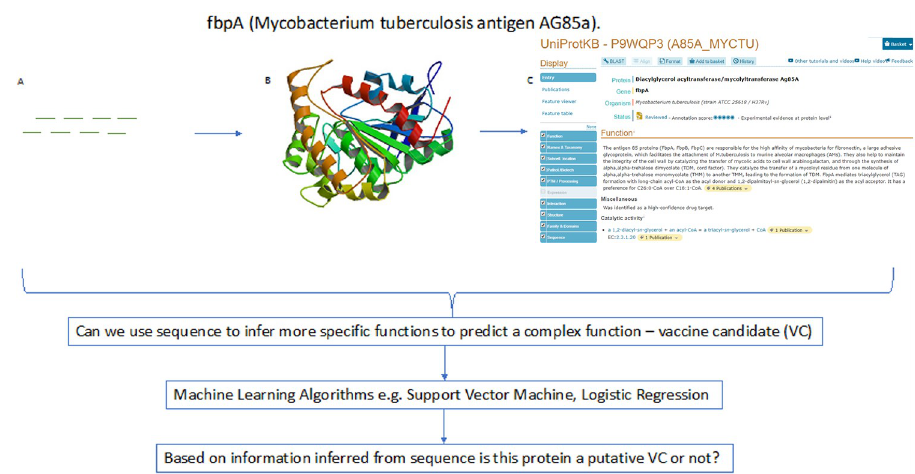
Fig 1. Depiction of the theory, can sequence infer function? The known vaccine candidate for mycobacterium tuberculosis[3] has many stages at which this can be evaluated, (a) the sequence, (b) structure[4] and (c) biological information[5] levels. The sequence information of proteins is the easiest information to obtain about proteins and therefore if we can predict high level biological information about a protein as a whole from a protein sequence data it can be extremely powerful. We apply the theory of sequence inferring function to vaccinology which utilized machine learning to make a prediction from sequence on the proteins function as a putative vaccine